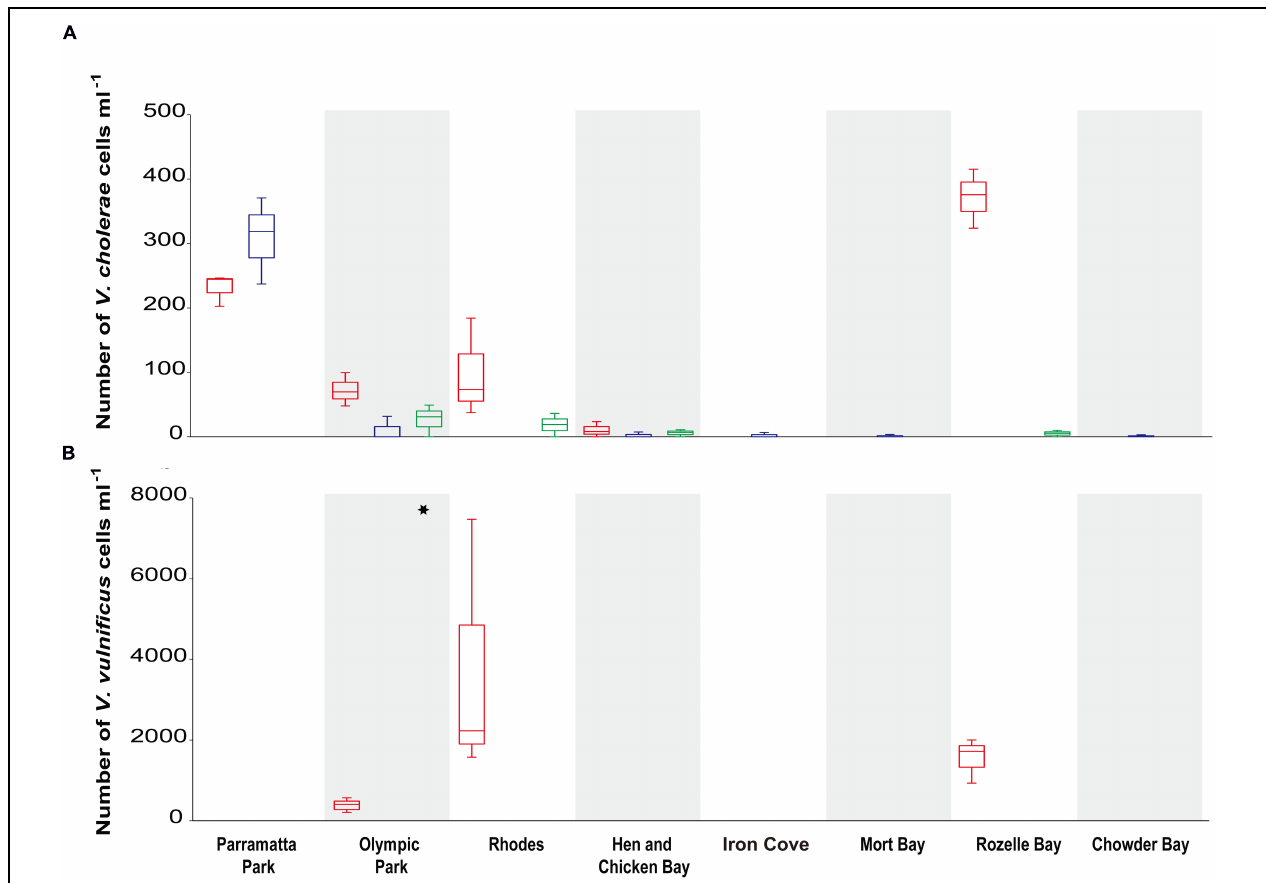
FIGURE 3 | Vibrio cholerae and V. vulnificus abundance (mL − 1 ) in Sydney Harbour determined by quantitative PCR. Specific qPCR assays were carried out on: (A) the V. cholerae outer-membrane protein gene ompW (Efficiency ≥ 93.3% and R 2 ≥ 0.996; top graph) and for (B) the V. vulnificus hemolysin A vvhA gene (Efficiency = 92.8% and R 2 = 0.995; bottom graph). Red boxplots denote summer (March) samples, and blue and green boxplots denote winter [June and August, respectively] samples. Asterisks indicate a significant difference in V. vulnificus between sample